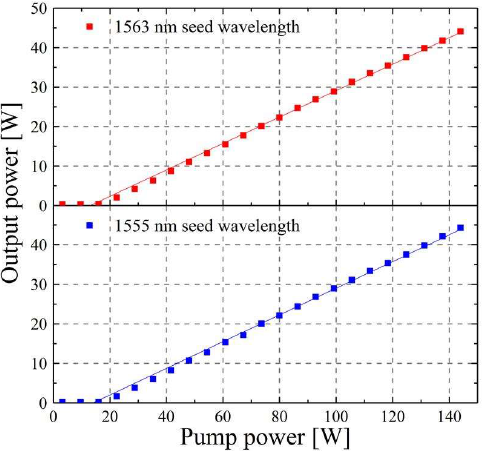
Figure 6. Characteristics of signal output power versus pump power in the case of the MOPA operating at 1555 nm and 1563 nm.